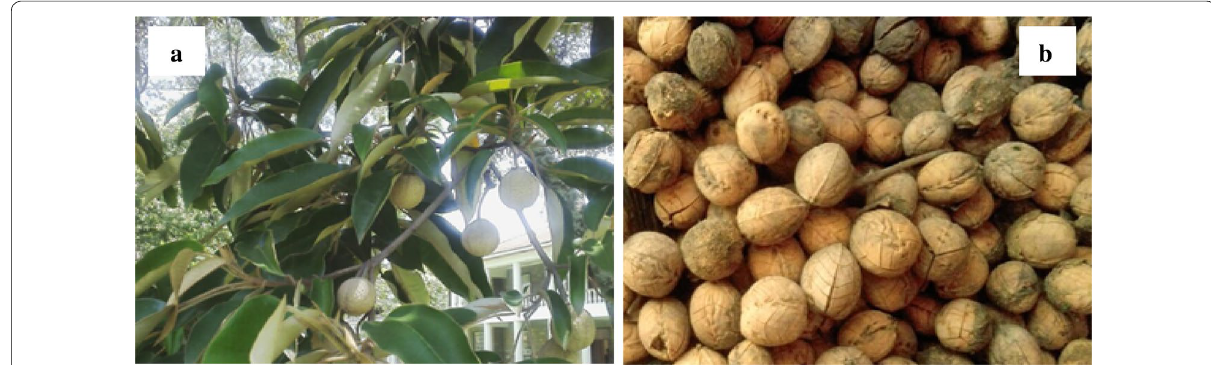
Fig. 1 The Croton megalocarpus plant ( a ) and croton seeds ( b ) (photos taken by the